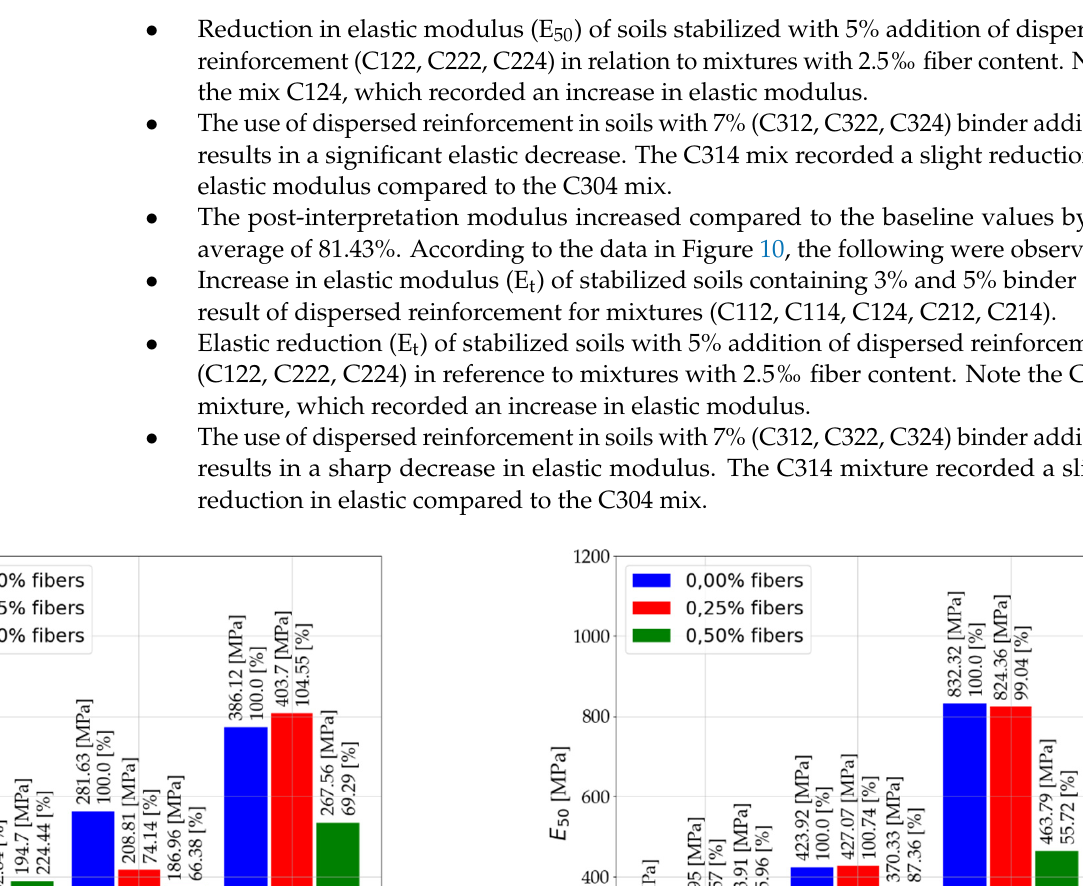
Figure 9. Values of secant modulus E (cid:2873)(cid:2868) after 28 days of care ( a ) before interpretation and ( b ) after interpretation.